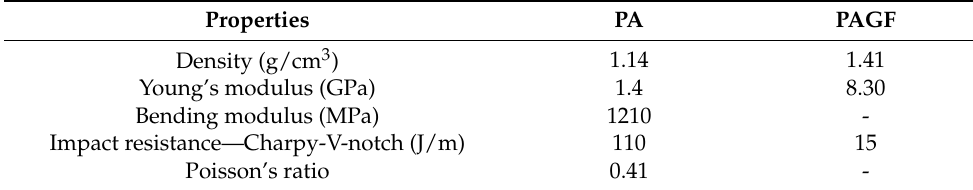
Table 1. Mechanical and physical properties of selected materials. Properties